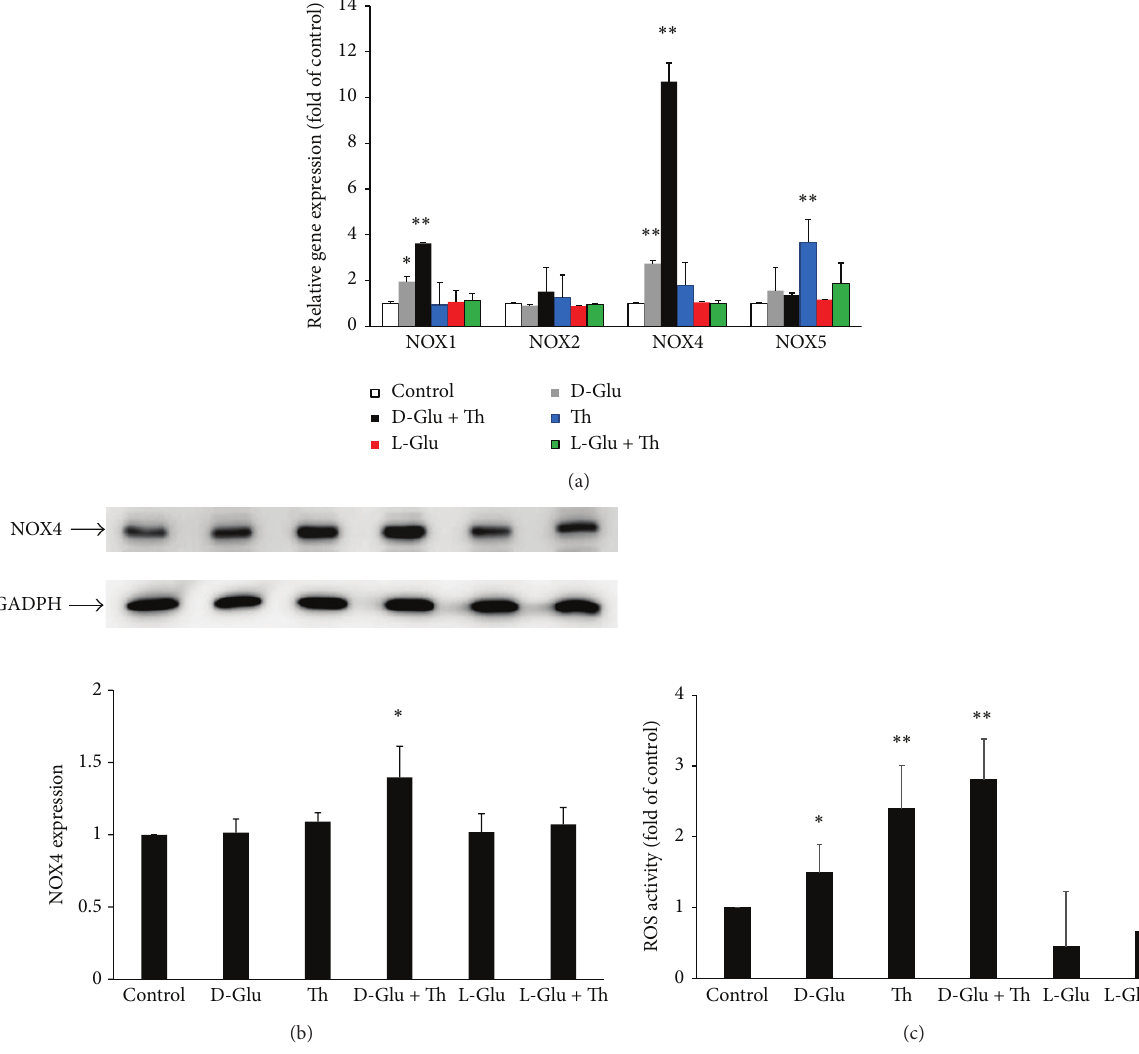
Figure 1: Endothelial Nox4 expression and intracellular ROS production were significantly induced by HG/thrombin. (a) HAECs were stimulated with HG (25mmol/L), L-glucose (25mmol/L), and thrombin (2U/mL) for 5 h. Real-time PCR showed that stimulation of HAECs with D-glucose/thrombin induced a 10.69-fold synergistic increase of Nox4 mRNA levels compared with the control, while L- glucose/thrombin had no such effect. The bars represent the means ± SEM from 3 experiments. ∗ 𝑃 < 0.05 , as compared with the control. ∗∗ 𝑃 < 0.01 , as compared with the control. (b) Stimulation of HAECs with HG/thrombin for 12h increased Nox4 protein expression 1.35-fold compared with the control; alternatively, L-glucose/thrombin had no discernible effect on Nox4 expression. The bars represent the means ± SEM from 4 experiments. ∗ 𝑃 < 0.05 , as compared with the control. (c) Stimulation of HAECs with HG/thrombin for 5h significantly increased ROS production 2.81-fold compared with the control. The bars represent the means ± SEM from 3 experiments. ∗ 𝑃 < 0.05 , as compared with the control. ∗∗ 𝑃 < 0.01 , as compared with the